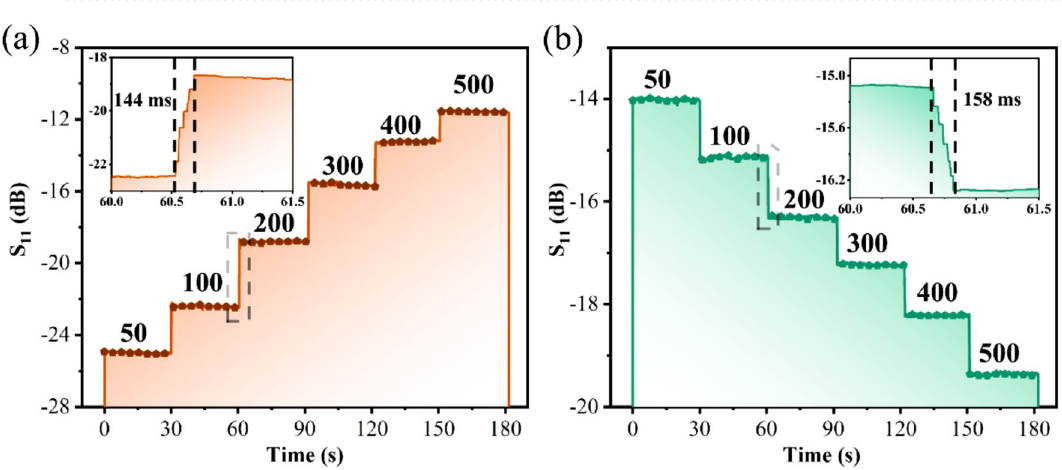
Figure 7. ( a ) The stability test results in the concentration range of 50–500 mg/dL for ( a ) bare biosensor chip and ( b ) the biosensor combined with the microfluidic device (the insets show the response time of the different solution